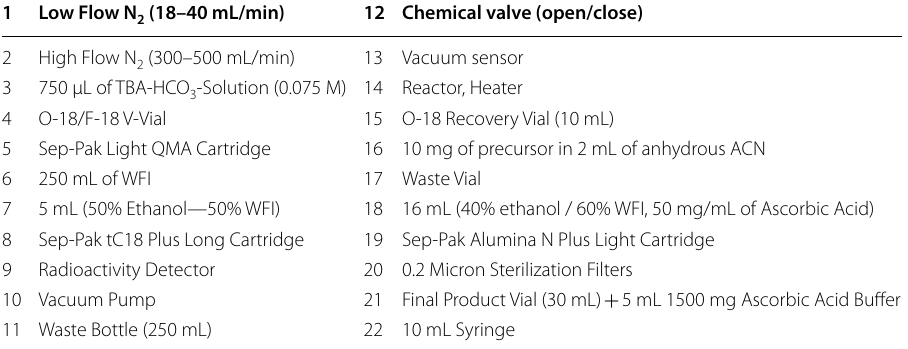
Table 2 Description of the schematic synthesis diagram (Fig. 5)